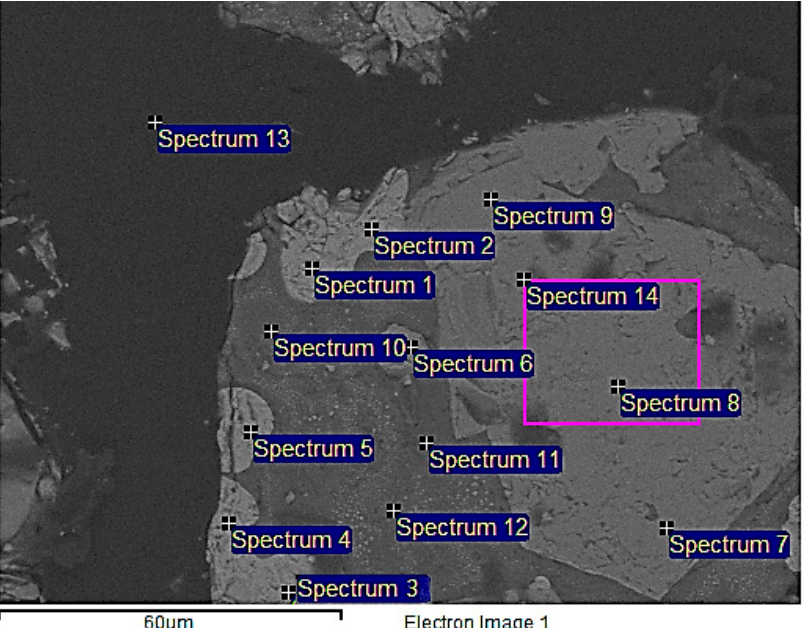
Figure 3. Back scattered Scanning Electron Microscopy (SEM) micrograph of the overall raw material.